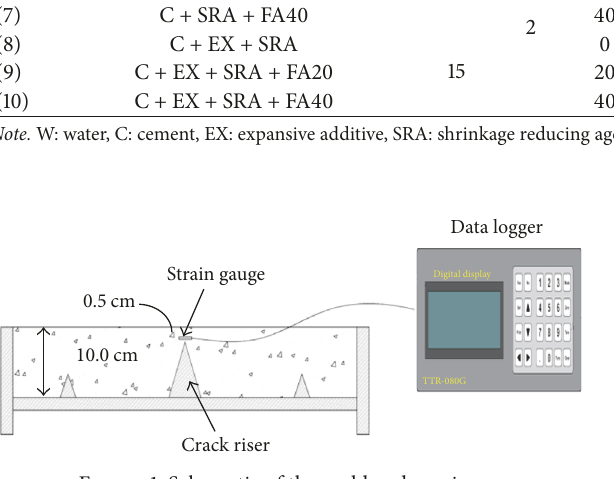
Figure 1: Schematic of the mold and specimen.